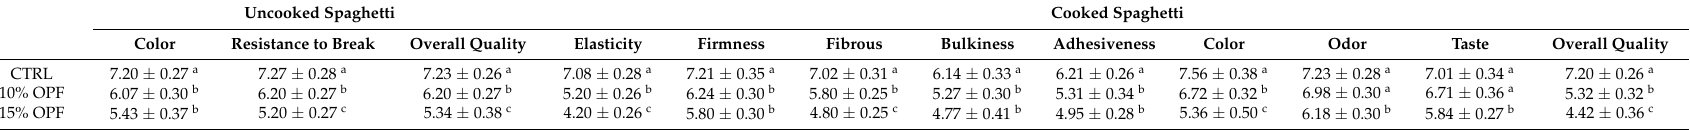
Table 2. Sensory characteristics of uncooked and cooked dry spaghetti samples investigated in the Step 2.